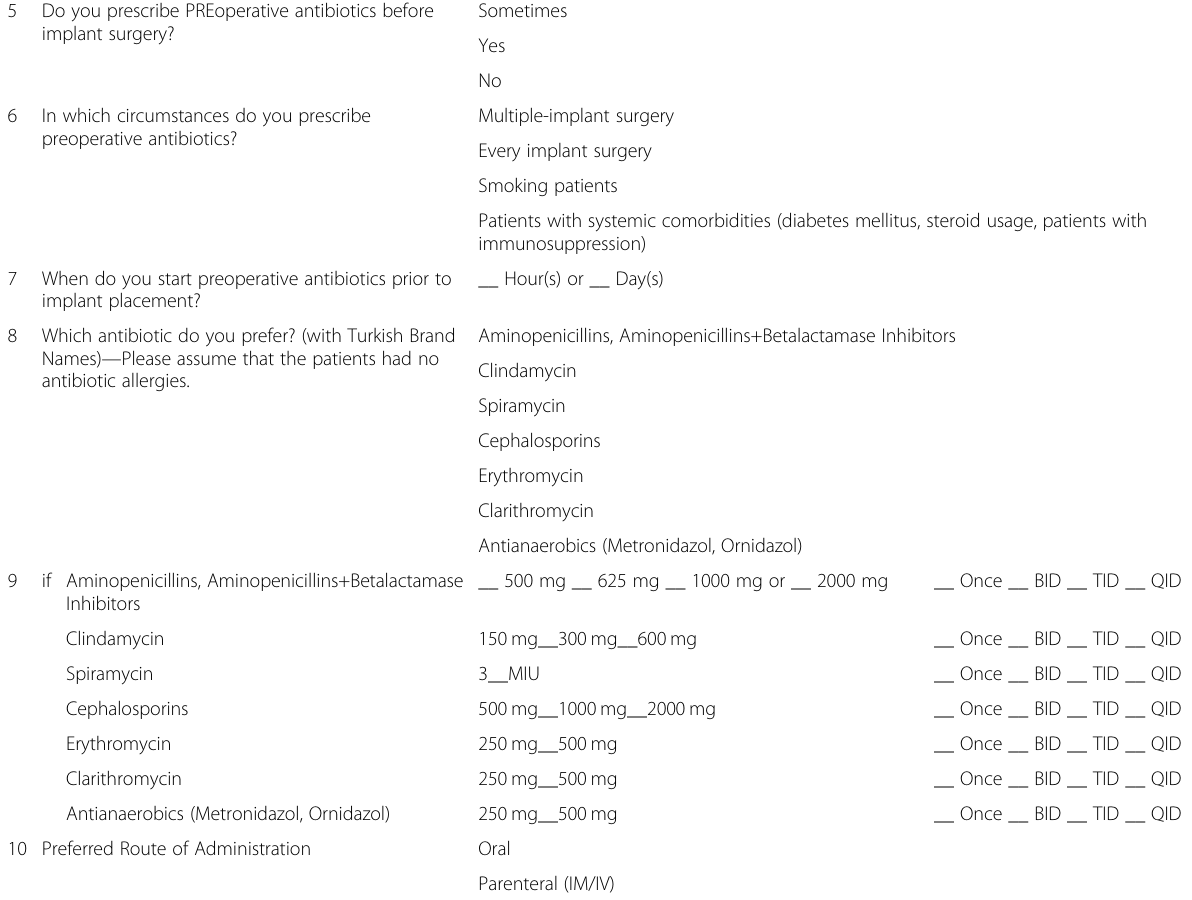
Table 2 Questions about PREoperative antibiotic prescription habits of the